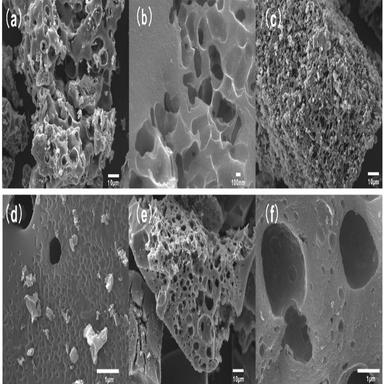
SEM images of carbon samples: KLK-1–600 (a, b), OKLK-1–600 (c,d) and OKLK-1–700 (e, f).